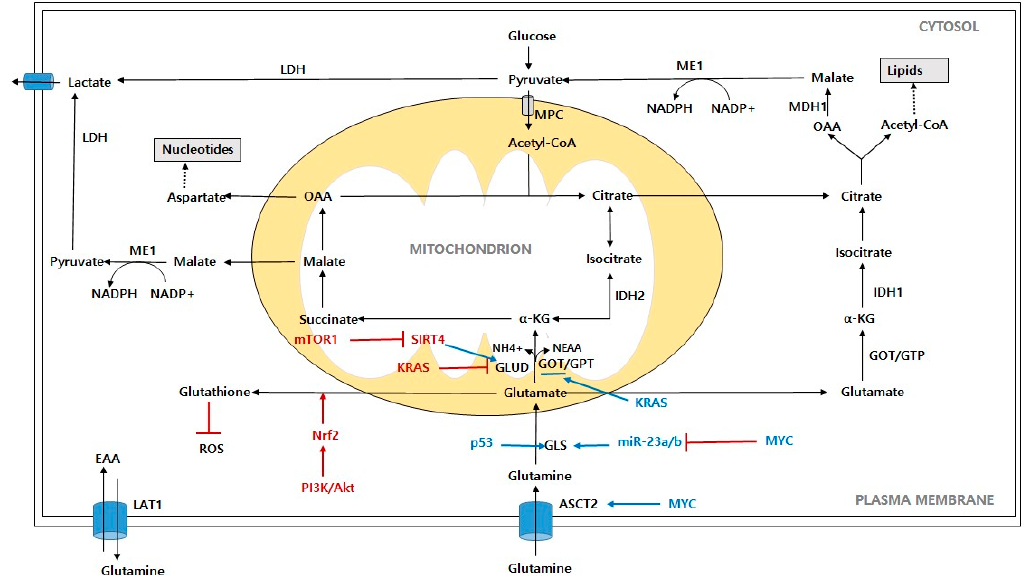
Figure 2. Schematic representation of glutamine contribution to cancer cells metabolism. Abbrevia- tions: ASCT2: alanine-serine-cysteine-transporter-2; LAT1: L-type amino acid transporter; GLS: